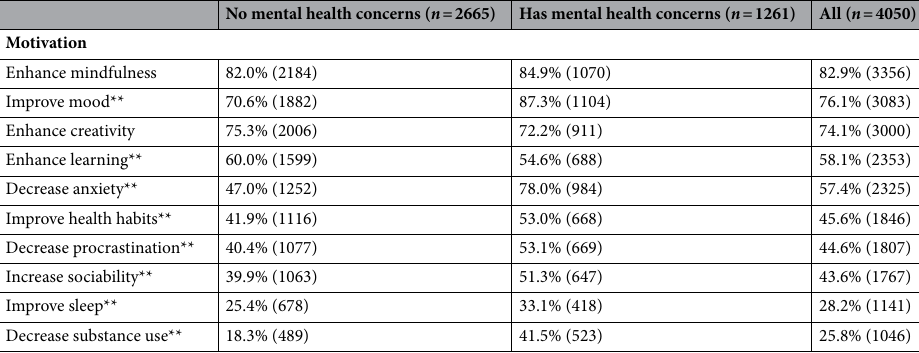
Table 3. Microdosing motives of respondents with and without mental health concerns. * *p < 0.01.